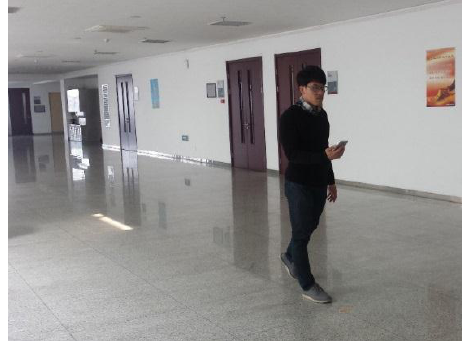
Figure 10. Attitude of the smartphone and the user’s gesture in the experiment.